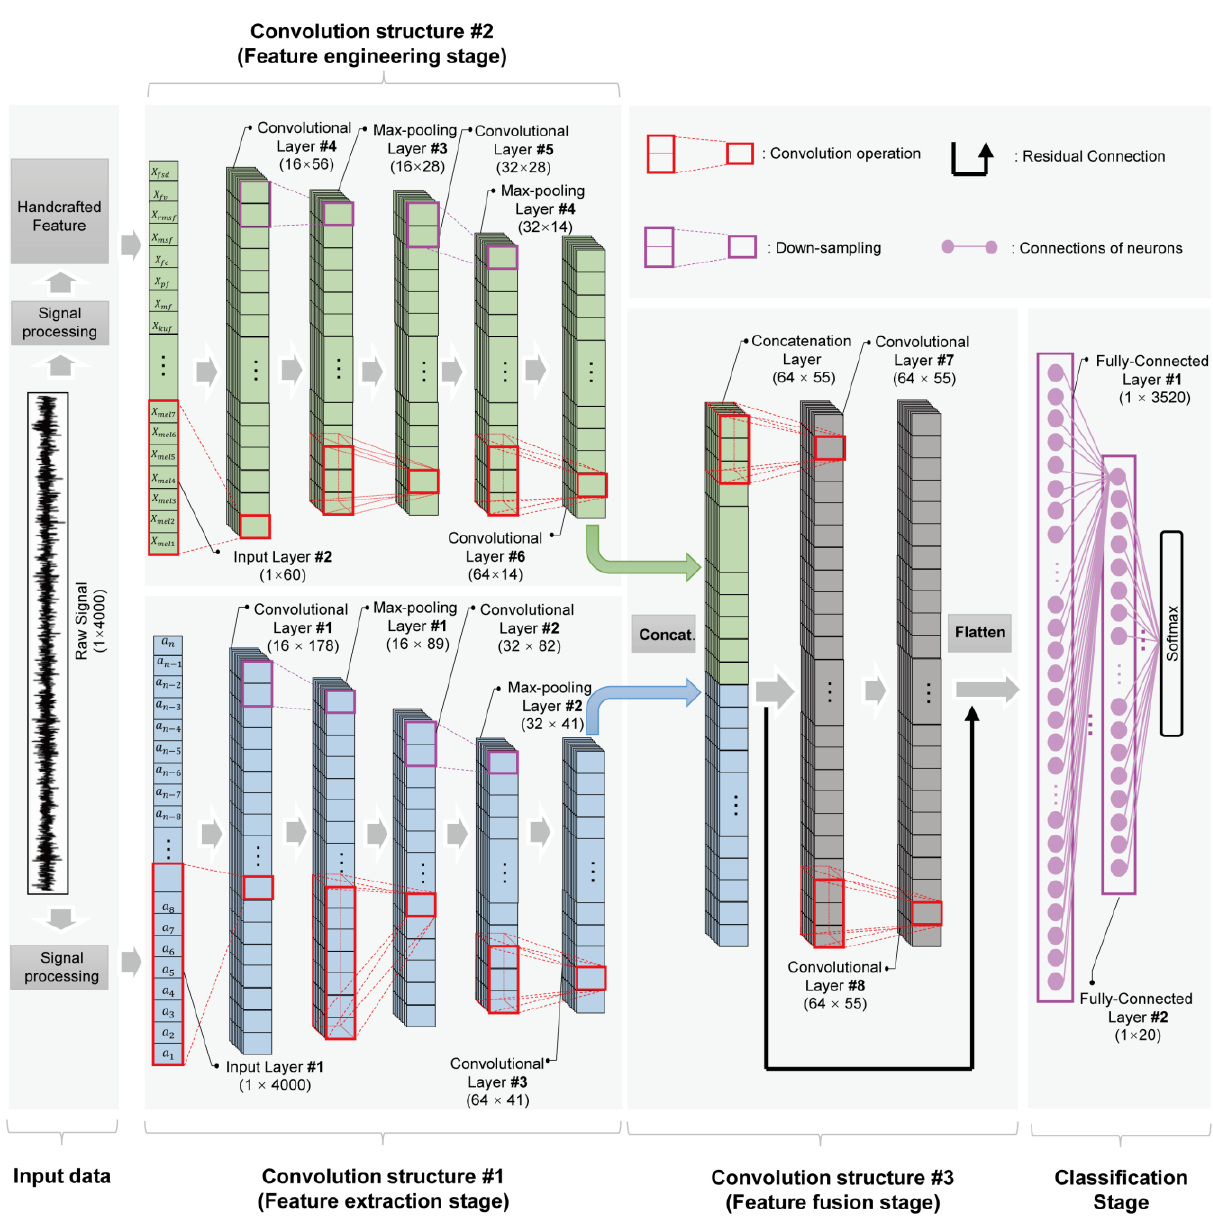
Figure 3. The architecture of the PCNN. The PCNN consists of two convolutional structures in parallel for processing inputs with different scales, a convolutional structure with residual connection for feature fusion, and a two-layer multi-layer perceptron for classification. The convolution filters and inputs of the model are in one dimension.